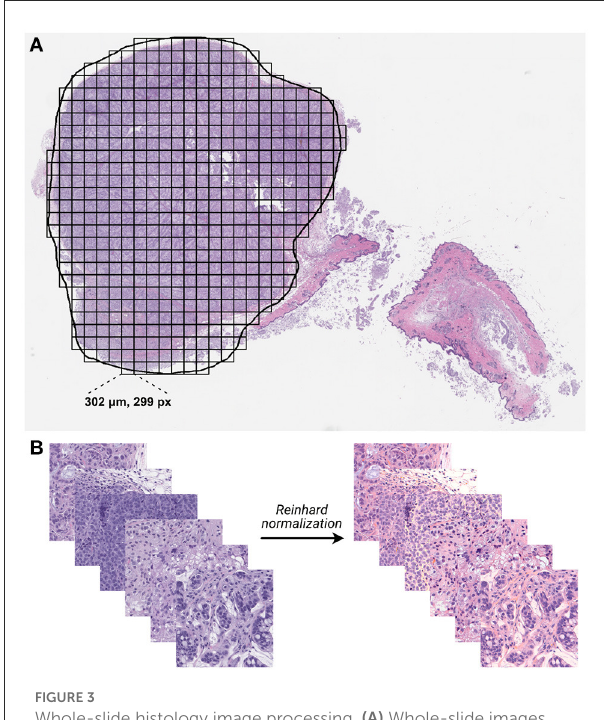
FIGURE3 Whole-slide histology image processing. (A) Whole-slide images were annotated with region of interest (ROI) outlines, and image tiles were extracted from within ROIs in a grid-wise fashion. (B) Extracted non-background tiles underwent digital stain normalization using the Reinhard method (44).